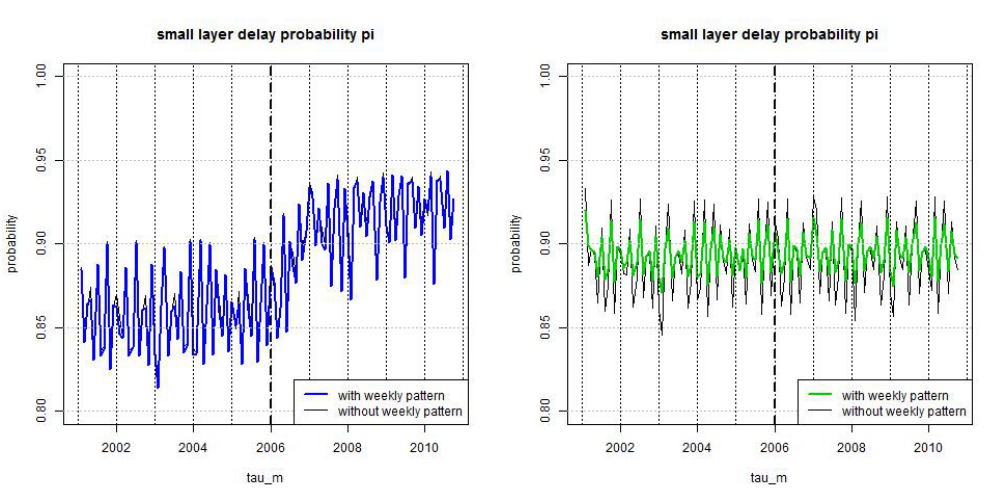
( m ,1 ) ( τ m ) , see (23), for τ m ∈ { 31/1/2001, . . . ,31/10/2010 } using Figure 4. Estimated probability π (cid:98) Θ ( τ m ) 1 weekly periodic pattern ( λ k ) k = 1,...,7 (blue/green) and setting ( λ k ) k = 1,...,7 ≡ 1 (black) for (lhs)